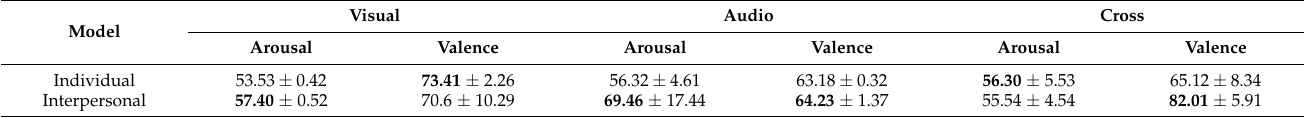
Table 7. The Supplementary Experiment Result